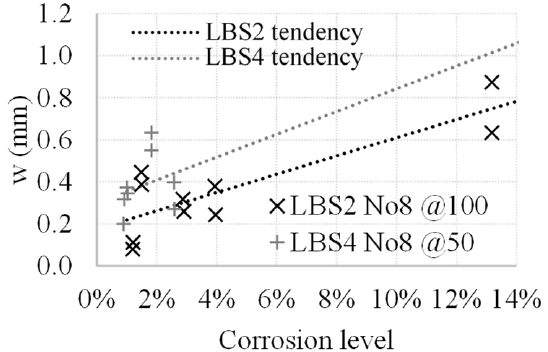
Figure 4. Yielding strength of reinforcing rebar.